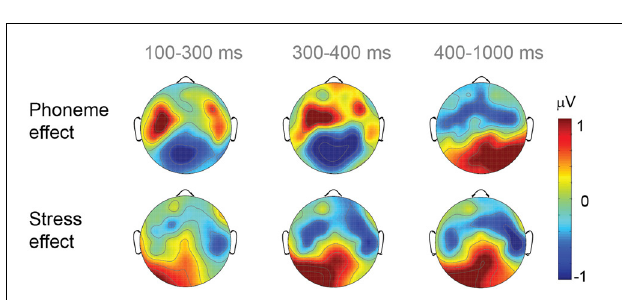
FIGURE 5 | Topographical voltage maps of the ERP phoneme-priming effect and stress-priming effect (match subtracted from mismatch, respectively) across all groups for the three analyzed time